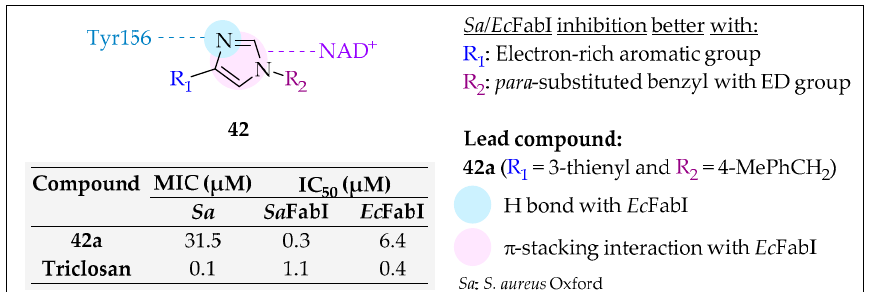
Figure 34. Structure, SAR and representation of main interactions with Sp FabK of phenylimidazole derivatives 39–41 and in vitro activities of lead compounds [158].